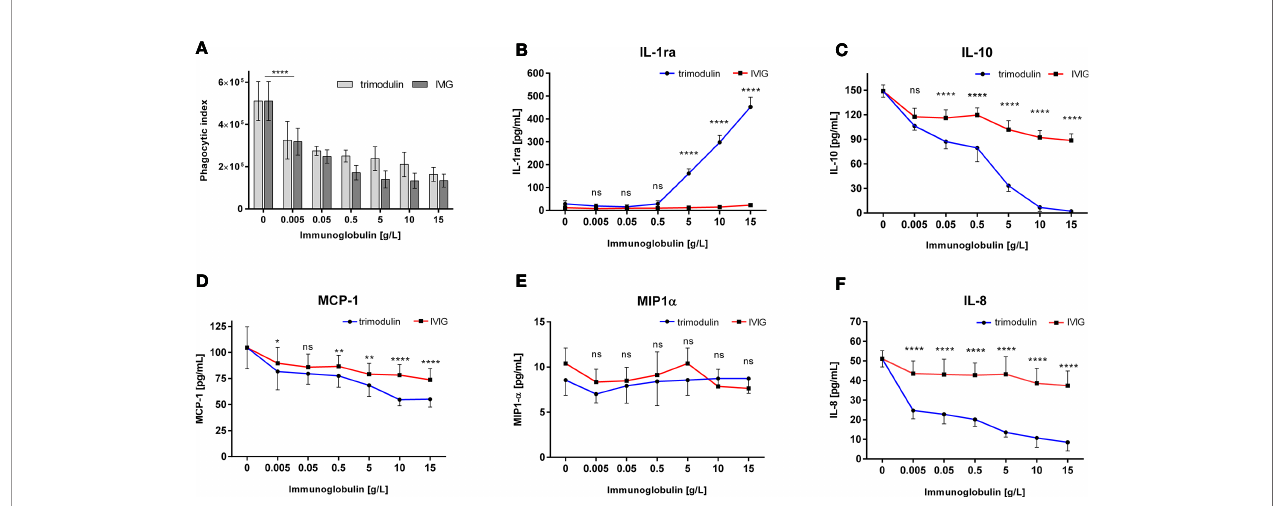
FIGURE 3 | Immune modulation in COVID-19-like model by IVIG and trimodulin preparation. (A) HL60 cells were incubated for 1 h with SARS-CoV-2 spike protein coated beads opsonized with COVID-19 plasma. IVIG ( IgG Next Generation , Biotest AG) or trimodulin (Biotest AG) was added in the indicated concentrations to the cell immune complex mixture. Phagocytosis of SARS-CoV-2-like immune complex was measured with trimodulin (light gray bars) or IVIG (dark gray bars) addition. (B – F) Same as (A) instead phagocytosis cytokine release into cell culture supernatant was measured with trimodulin (dots, blue line) or IVIG (square, red line) addition. IL1-ra (B) , IL-10 (C) , MCP-1 (D) , MIP-1 a (E) , and IL-8 (F) were measured. Values represent mean of six independent experiments. Statistics: Two way ANOVA; Tukey ’ s multiple comparisons test, 95% con fi dence interval. ns, not signi fi cant, *p ≤ 0.05, **p ≤ 0.01, ****p ≤